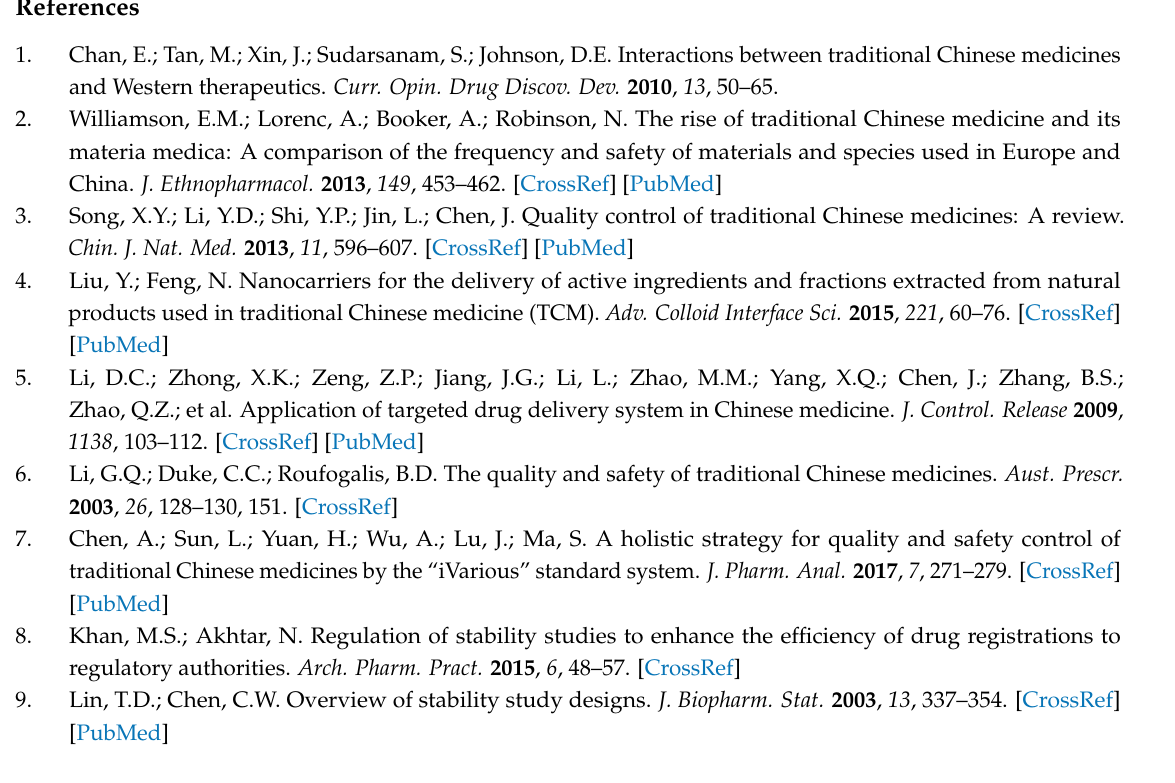
Supplementary Materials: The following are available online. Figure S1: Chemical structural formula of CGA, CGA-ME, and CGA-LT; Figure S2: MS (A) and MS 2 (B) spectra and proposed fragmentation pattern (C) of CGA; Figure S3: MS (A) and MS 2 (B) spectra and proposed fragmentation pattern (C) of CGA-ME; Figure S4: MS (A) and MS 2 (B) spectra and proposed fragmentation pattern (C) of CGA-LT; Table S1: Characterization of the degradation products of CGA, CGA-ME, and CGA-LT by UPLC-DAD/ESI-Q-TOF